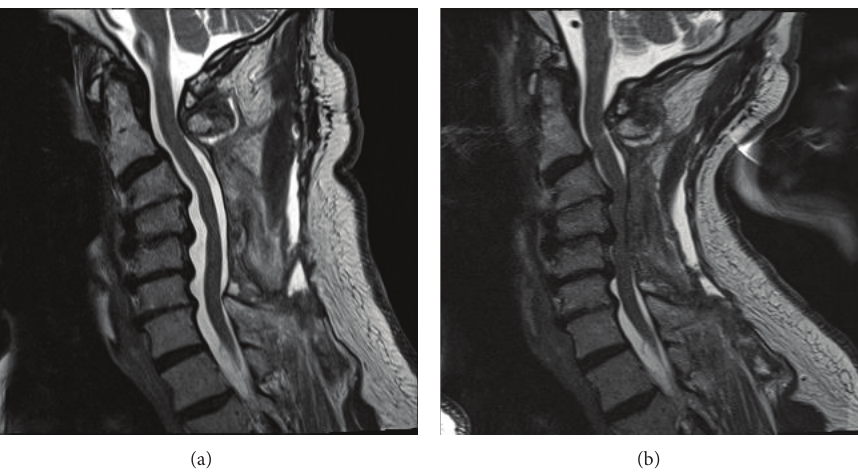
Figure 2: Postoperative T2-weighted sagittal MRI (flexion and extension): spinal cord is compressed by dorsal musculature when the neck is extended. Subaxial spinal alignment (Cobb angle) does not change with flexion-extension, reflecting rigidity of the patient’s spondylotic